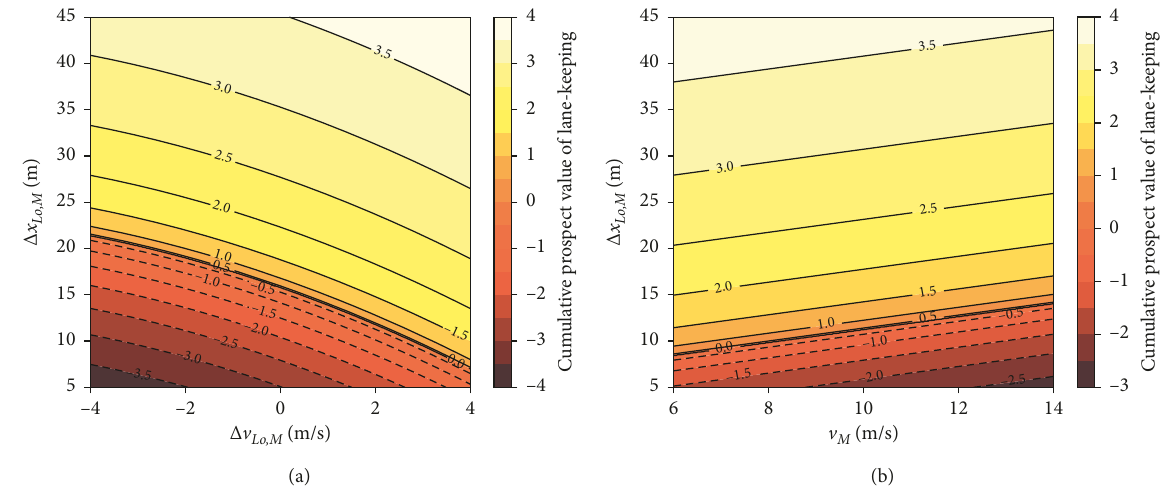
Figure 7: Contour plots of the cumulative prospect value of lane-keeping (a) as function of function of v M and